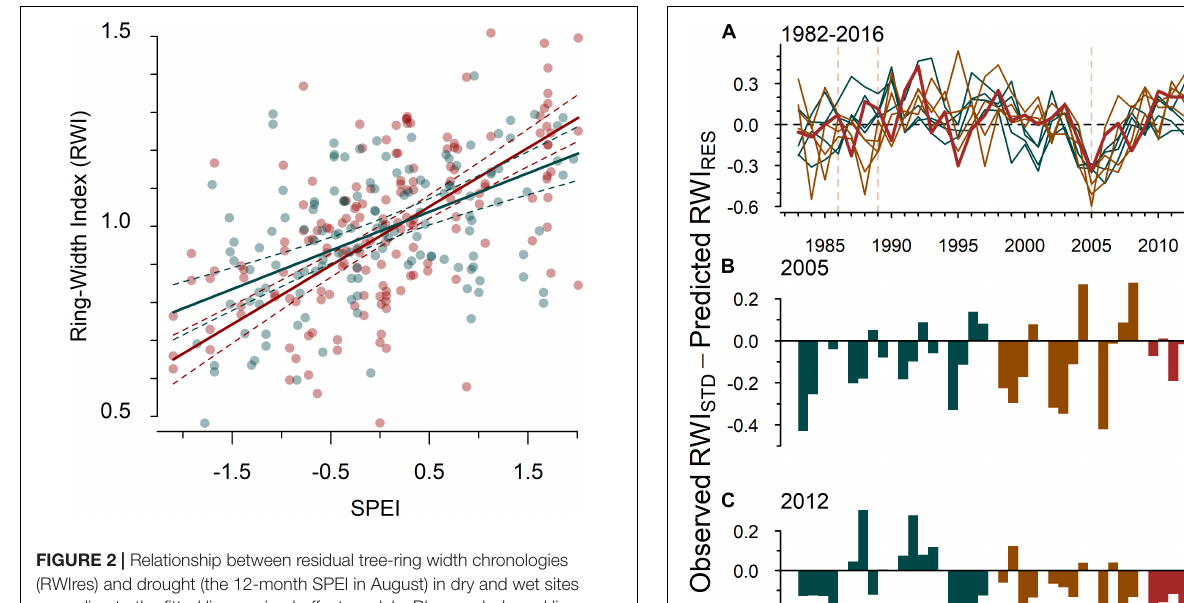
( Supplementary Figures S7, S8 ), which were more marked in